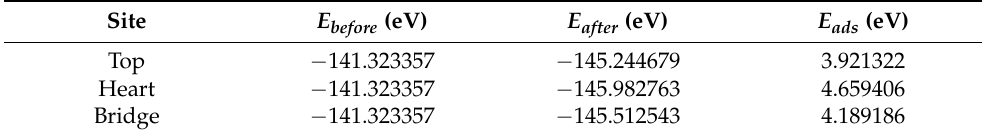
Table 2. Adsorption energy of each adsorption